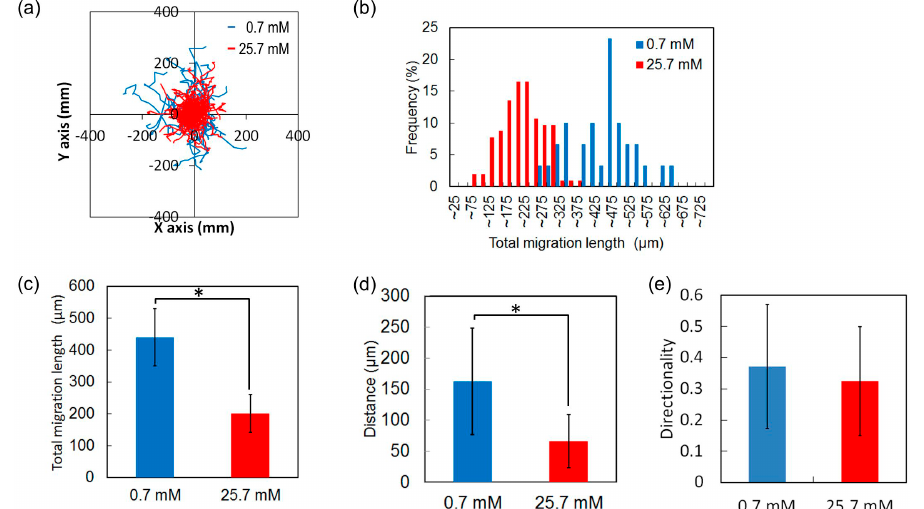
Figure 16. Mobility of HeLa cells at low and high glucose concentrations over a period of 24 h. ( a ) Trajectories of HeLa cells; ( b ) Histogram of the total migration length; ( c ) Average total migration length; ( d ) Travel distance from the origin; ( e ) Directionality along the y-axis. * p < 0.01 ( t -test).